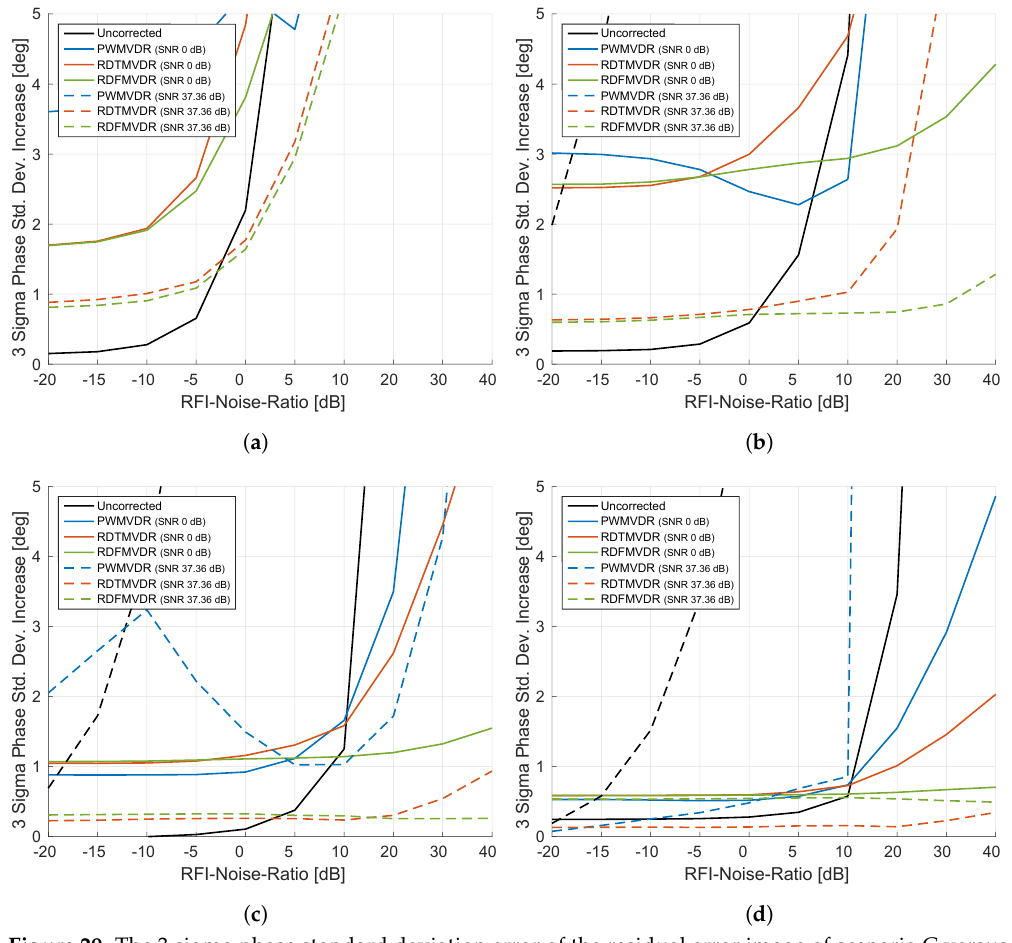
Figure 29. The 3 sigma phase standard deviation error of the residual error image of scenario C versus RFI-Noise-Ratio. The plots are shown for SNR = 0 dB (solid lines) and SNR = 37.36 dB (dashed lines). ( a ) N = 2, ( b ) N = 4, ( c ) N = 8, ( d ) N =